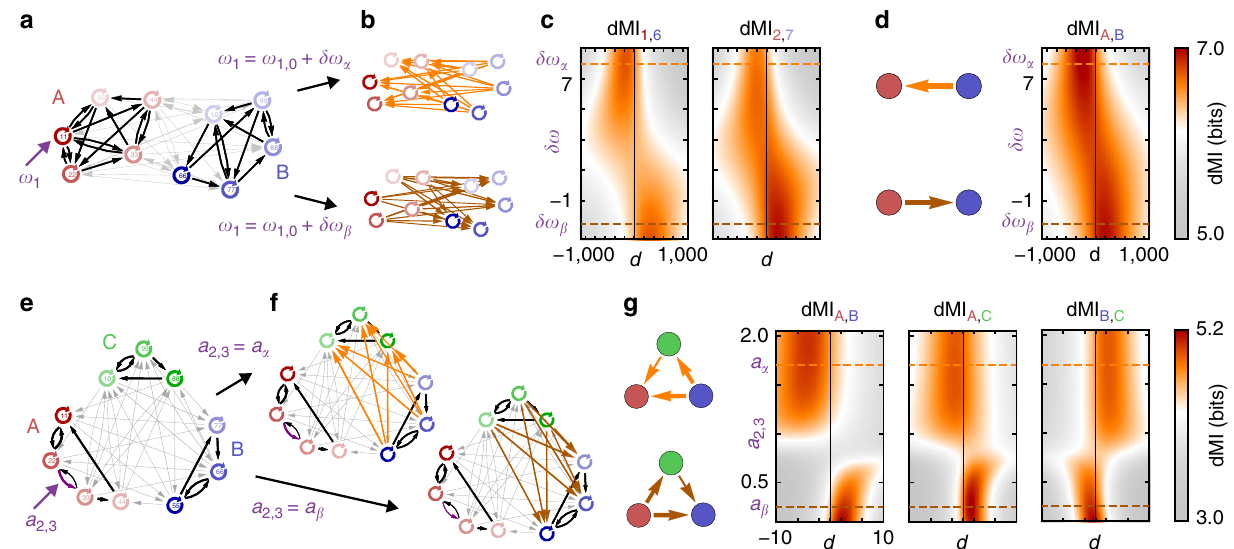
Figure 3 | Remotely induced rerouting of information in modular networks. ( a ) Network with two coupled communities A and B (red and blue) of oscillators close to a Hopf bifurcation. Changing the intrinsic frequency of a single node i ¼ 1 from o 1 þ do a to o 1 þ do b induces a collective reorganization of equilibrium phase differences, that result in b oppositely directed information sharing patterns between the individual nodes of the two modules (top versus bottom). ( c ) dMI between two pairs of nodes from the two different clusters as a function of the time delay d and frequency change do 1 of oscillator 1. The change of the peak from positive to negative delays reflecting the inversion of the information routing is visible. ( d ) Information routing patterns (IRPs) calculated from the hierarchically reduced system for the two configurations in b (left) and as a function of do 1 (right) reflect the inversion on the finer scale ( b , c ). ( e ) Hierarchical network of three coupled modules of phase oscillators. ( f ) A change in the connection strength a 2,3 from a a to a b between two nodes (3 A - 2 A ) in sub-network A induces an inversion of information routing direction between the remote sub-networks B and C . ( g ) Full IRPs calculated form the hierarchical reduced system for a 2,3 ¼ a a and a 2,3 ¼ a a (left) and as a function of a 2,3 for all pairs of modules (density plots, right). The transition is not continuous but rather switch